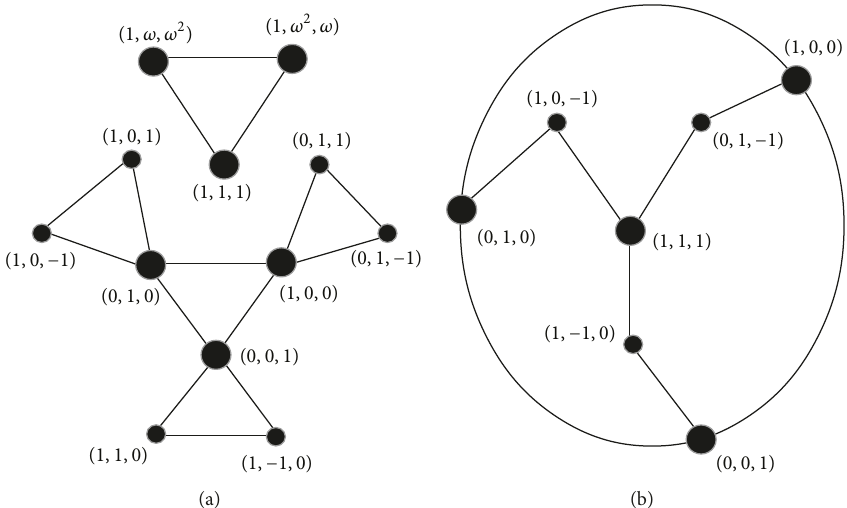
Figure 1: (a) Triples of mutually orthogonal rays arising from qutrit permutation gates; (b) three pentagons originating from the rays. Big black bullets are for stabilizer states; small bullets are for magic states.